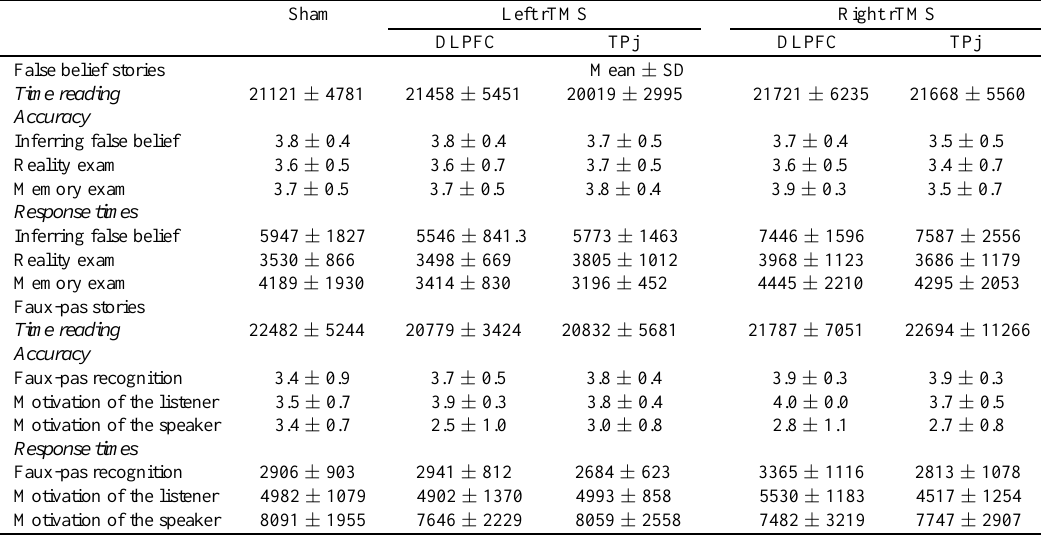
Average accuracy and response times obtained by subjects in theory of mind tasks